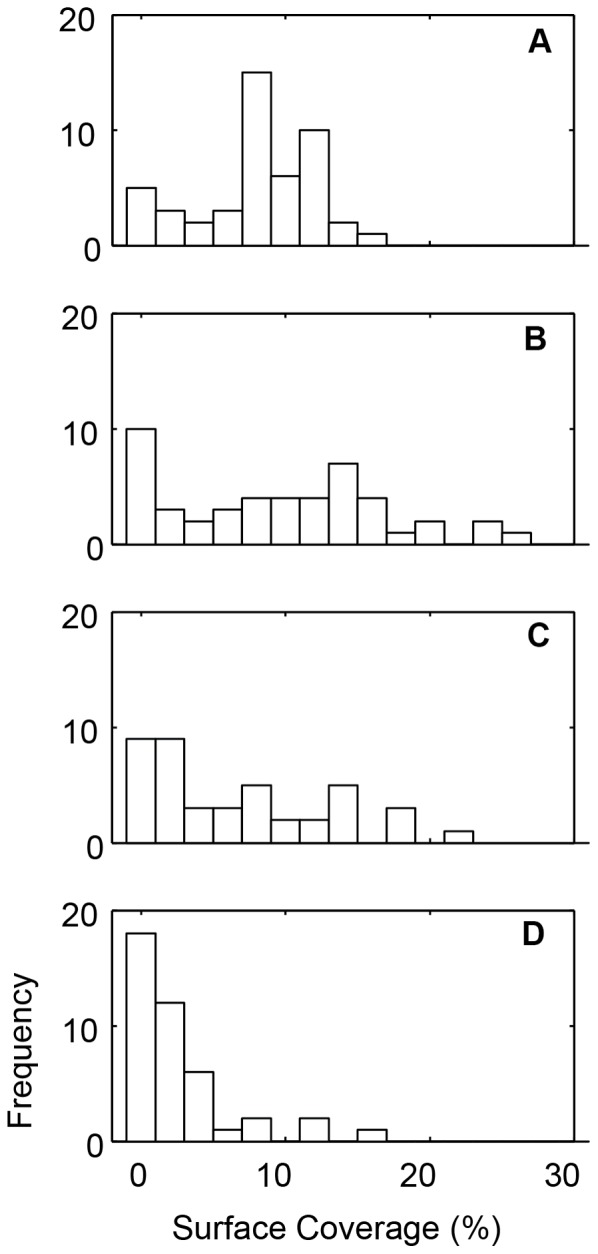
Distribution of platelet surface coverage (SC) in cohort of normal donors.Histogram of percent surface coverage (SC) for 150 s−1 (A), 300 s−1 (B), 750 s−1 (C), and 1500 s−1 (D) for the fifty normal donors.